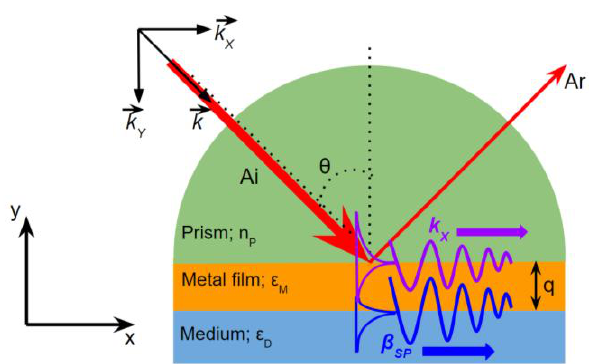
Figure 3. SPR excitation by prism coupling using Kretschmann configuration. Biosensors 2018 , 8 , x FOR PEER REVIEW